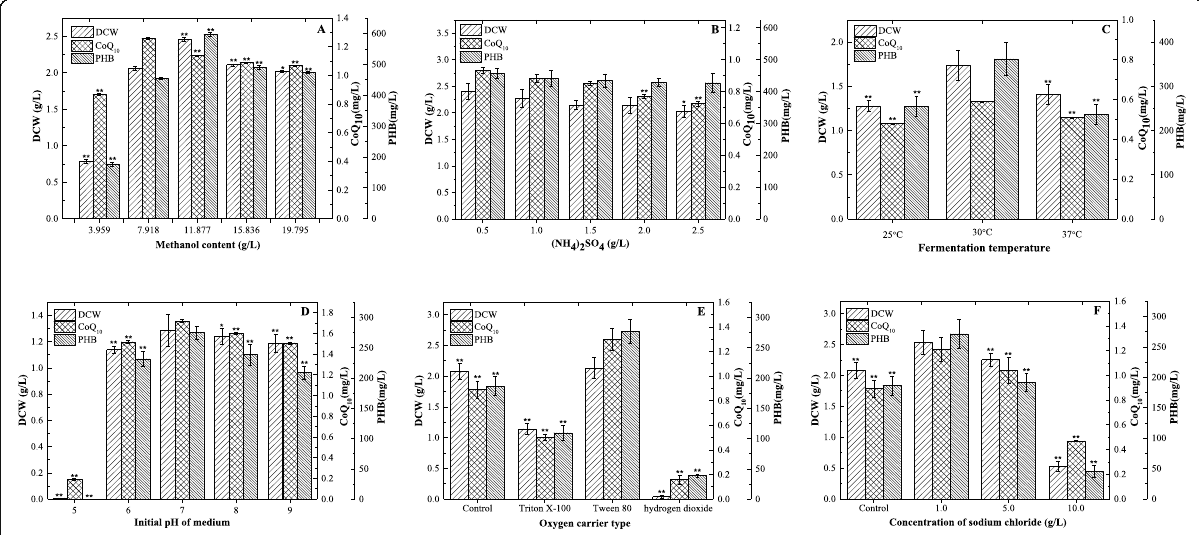
Fig. 6 Effects of methanol concentration ( a ), ammonium sulfate concentration ( b ), fermentation temperature ( c ), initial pH of medium ( d ), different oxygen carriers ( e ), and sodium chloride concentration ( f ) on XJLW biomass, PHB and CoQ 10 biosynthesis. Significant differences from selected group (7.918 g L -1 methanol group for a , 0.5 g L -1 (NH 4 ) 2 SO 4 group for b , 30 °C group for c , pH 7.0 group for d , Tween 80 group for e , and 1.0 g L -1 sodium chloride group for f , respectively) are indicated by * p < 0.05; ** p <